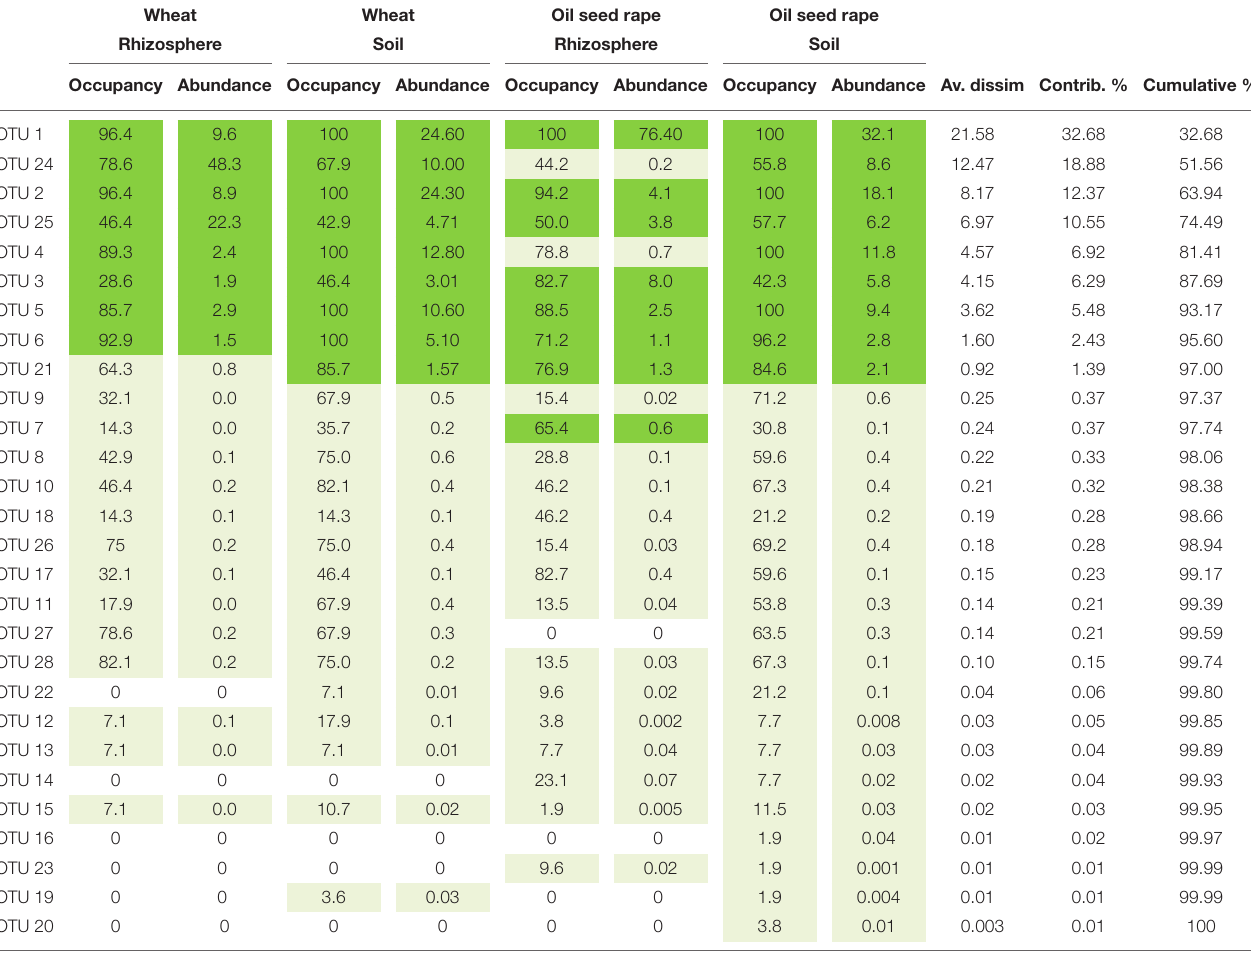
TABLE 1 | Similarity of percentages (SIMPER) analysis of community dissimilarity (Bray-Curtis) between plasmodiophorid metacommunities from each habitat. Wheat Wheat Oil seed rape Oil seed rape Rhizosphere Soil